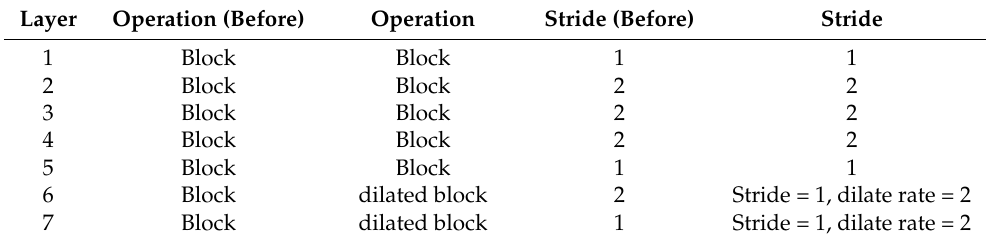
Table 1. Comparison of network parameters before and after modification.